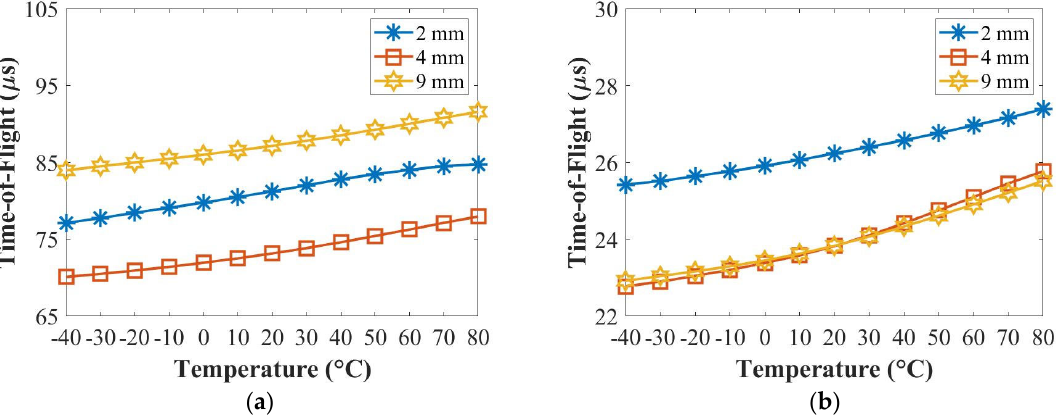
Figure 9. Relationships of the temperature with the time of flight at 50 kHz ( a ) and 250 kHz ( b ). Overall, the amplitude of the A 0 mode reduced with the increased temperature for all panels, which was not dependent on thickness, while that of the S 0 mode had different trends for panels of different thicknesses. In addition, the group velocities became slow for both the A 0 and the S 0 modes for all those panels with the increase in temperature, which were not dependent on thickness. Temperature changes can be attributed to the following factors: First, the piezoelec ‐ tric constants d 31 and g 31 vary with the temperature [40,43–45]. These piezoelectric con ‐ stants are associated with the shear strain and the piezo sensitivity, which affects the out ‐ put amplitude of signals. In addition, thermal expansion also affects changes in the thick ‐ ness of the panel, wave propagation and material density, which are key parameters to compute dispersion curves under different temperatures [40]. Next, the temperature has a large effect on the resin properties. The resin is more brittle under a very low temperature, while it is softer under a higher temperature. The change in the resin alters the engineering properties of the composite laminate, which causes a change in the shear modulus. The resin interfaces with the carbon, which is sen ‐ sitive to the temperature and the glass transition temperature. Furthermore, higher residual strains remain after the curing process inside the lami ‐ nate when manufacturing the composite laminate. Temperature can affect the residual strains. The efficiencies of the engineering properties could be the residual strains built into the laminate. All of this could affect the temperature. Therefore, it is very important to define the relationship between the phase and the velocity change for composite panels, depending on their thicknesses, so that the compensation algorithm can be applied and damage detection can be carried out under different temperatures reliably. 6. Damage Detection and Localisation In this section, the damage index (DI) correlation coefficient [41] was used to evaluate the damage severities of the structure by comparing the difference between the baseline signals and the current signals. The delay ‐ and ‐ sum (DAS) algorithm [46,47] was used to locate the damage position. To demonstrate the difference between the guided wave in ‐ teraction with through ‐ thickness damage (i.e., interlaminar delamination due to an im ‐ pact event) and surface damage (i.e., debonding between two structures), the impact dam ‐ age and the artificial damage were introduced to the plates with different thicknesses. The surface ‐ mounted artificial damage (weighted Blu Tack) was used in the first instance to simulate the surface damage (in this case, it was the increased mass) which was also re ‐ versible before the plates were impacted to cause barely visible impact damage.